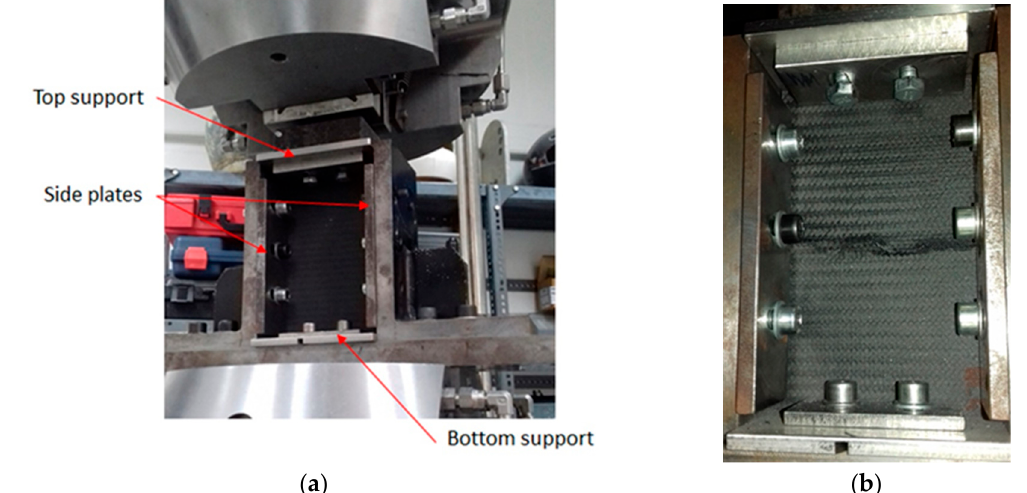
Figure 3. Illustration of ( a ) Compression after impact test fixture with a specimen positioned in place and ( b ) a valid broken specimen after the damage tolerance after impact (CAI)